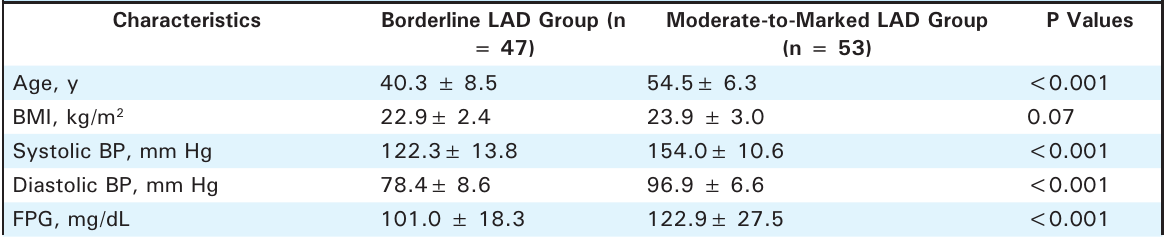
Table 2. Mean and standard deviation values of characteristics of the participants in the two LAD groups.